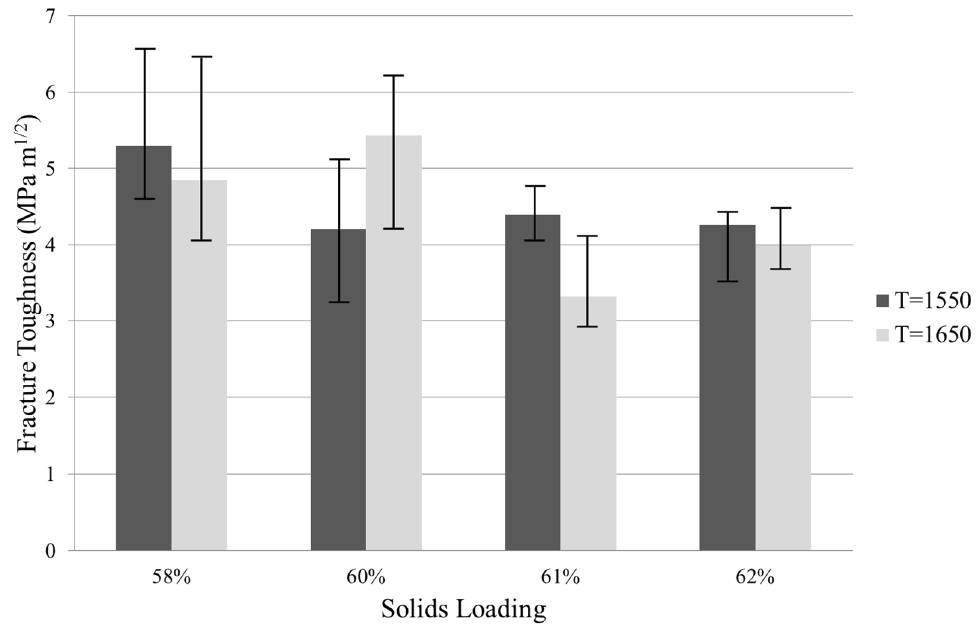
Figure 7. Fracture toughness values obtained by optical microscopy for solid loadings ranging from 58%–62% at sintering temperatures of 1550 °C and 1650